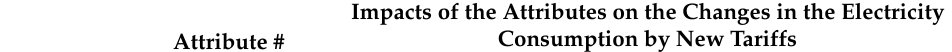
Table 9. Sensitivity analysis using the developed ELM: impacts of building attributes on the low, medium, and high usage